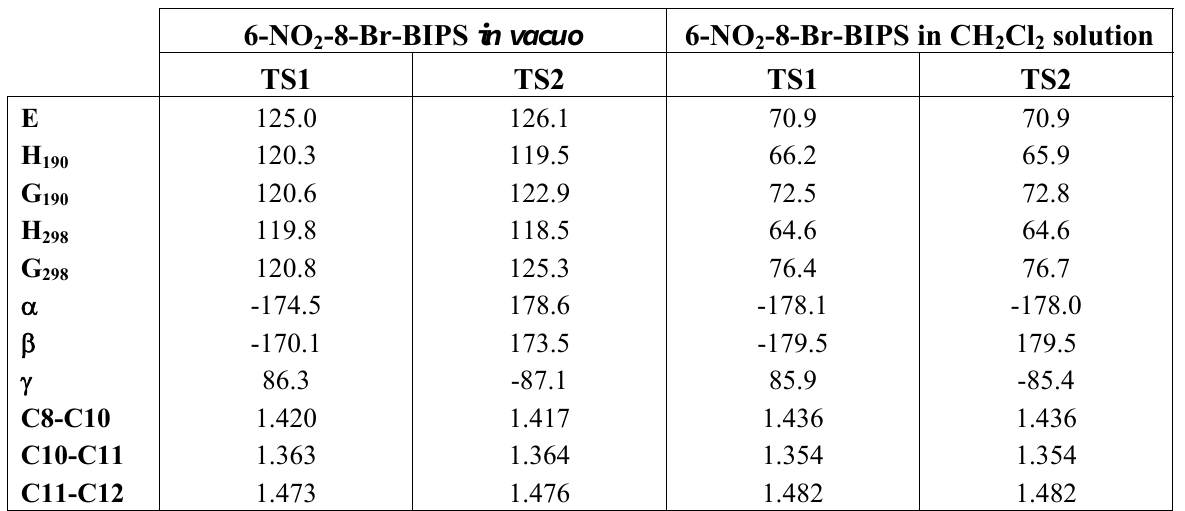
Table 2. Relative energies (kJ ⋅ mol -1 ) and relevant torsional angles (degrees) and bond lengths (Å) of the transition states in the isomerization reaction TTC → TTT of 8-bromo- 6-nitro-BIPS in vacuo and in methylene chloride solution at different temperatures. Zero energy reference values are those of the TTC